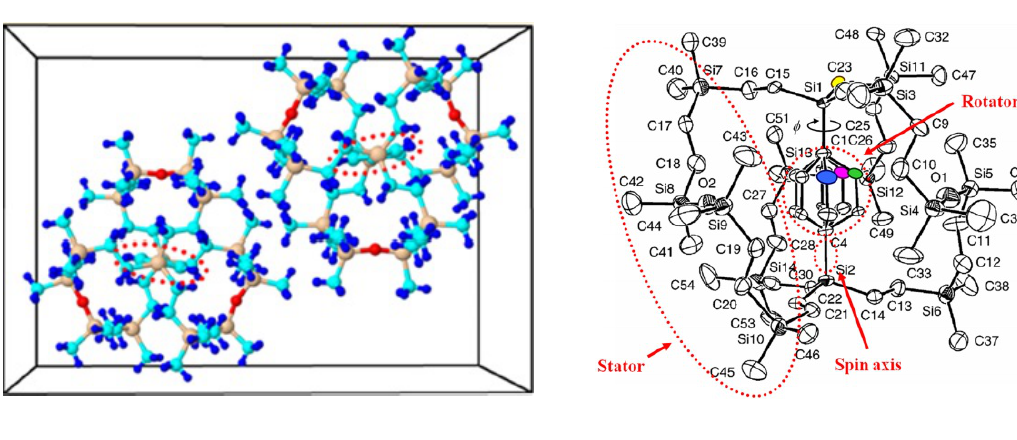
Figure 22. Molecular Gyroscopes.